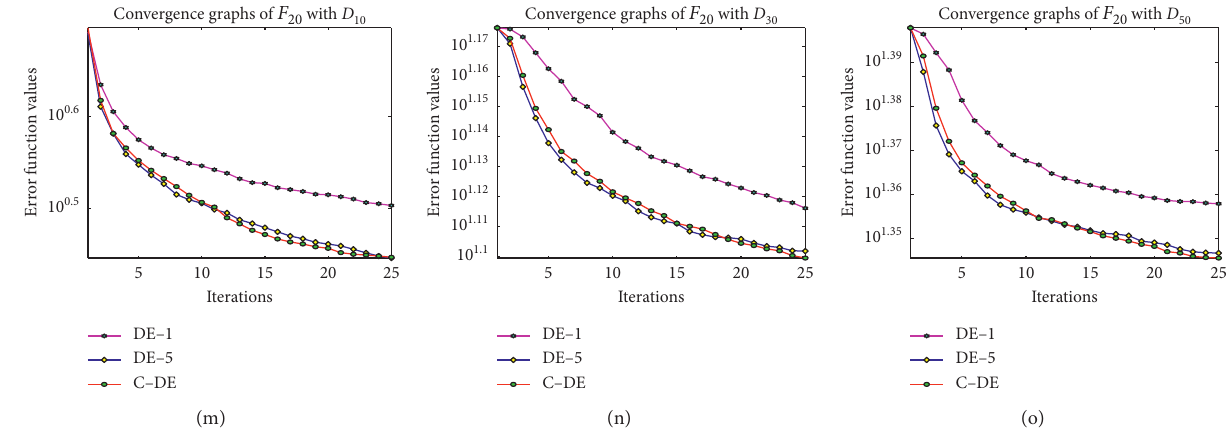
Figure 5: Evolution in the best function values of F